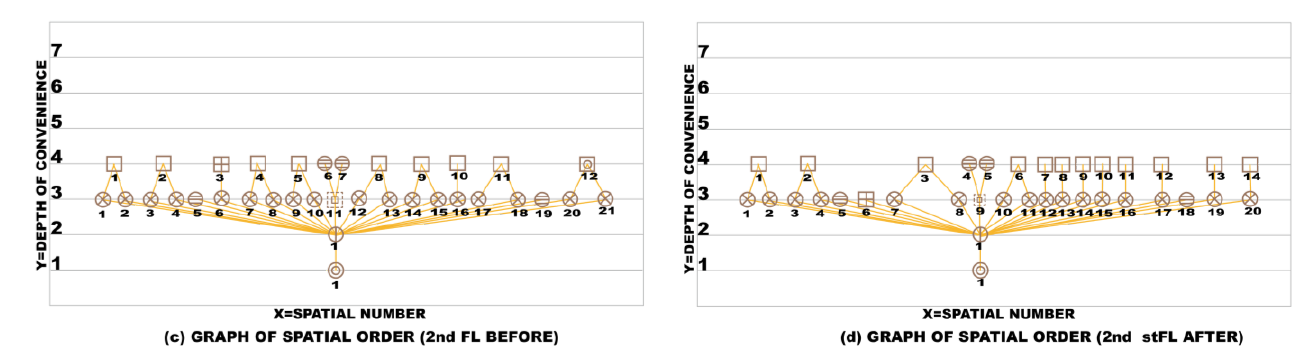
Figure 11. Past and Present’s Regeneration Second Floor Plans of Nanhua Elementary School Space Relationship Diagrams. ( a ) Spatial Analysis (Before redesign). ( b ) Spatial Analysis (Before redesign). ( c ) Spatial Order (Before redesign). ( d ) Spatial Order (After redesign).